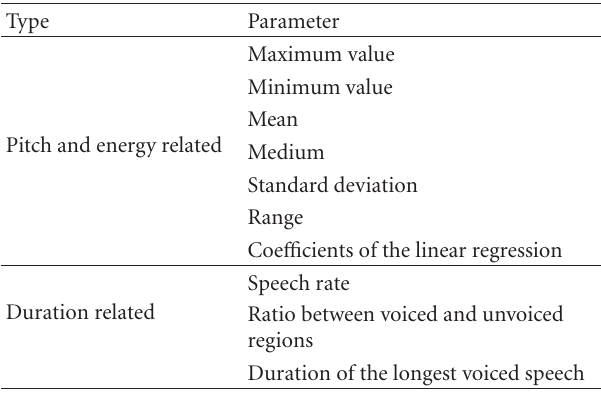
Table 2: Prosodic